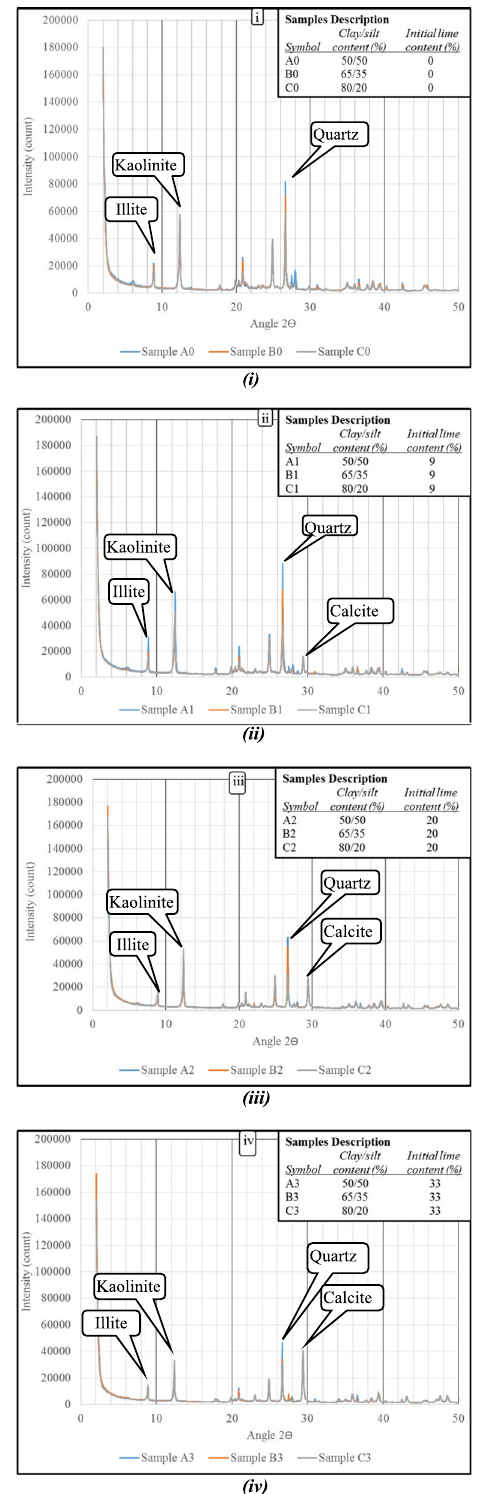
Fig. 7 X-Ray diffraction analysis of manufactured samples (i) initially constituted primary soils, (ii) moderately calcareous, (iii) strongly calcareous and (iv) very strongly calcareous